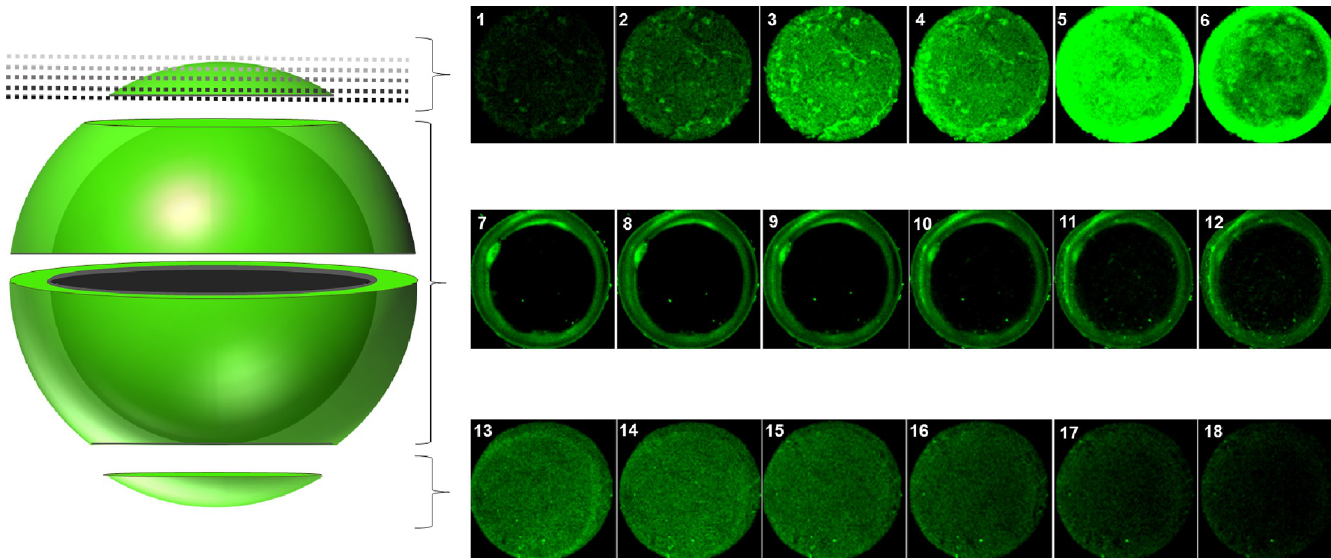
Fig 4. Confocal Z-stack image sequence of a denuded oocyte. Images of a denuded oocyte co-incubated with BHV1 for 24 h in a sequence of different focal planes (step size of 1 μ m) elucidating the presence of BHV1 (bright green dots) within the oocyte and on the outer face of the zona pellucida.